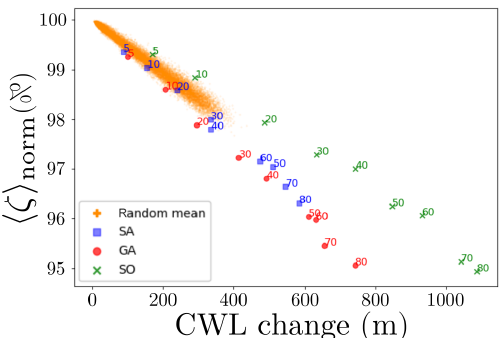
Figure 8. Correlation between (cid:104) ζ (cid:105) and the CWL change for the random and the optimized block configurations. A larger block- induced change in CWL leads in general to a WTD closer to the surface. The number that accompanies each one of the points stands for b , the number of blocks that were located for each